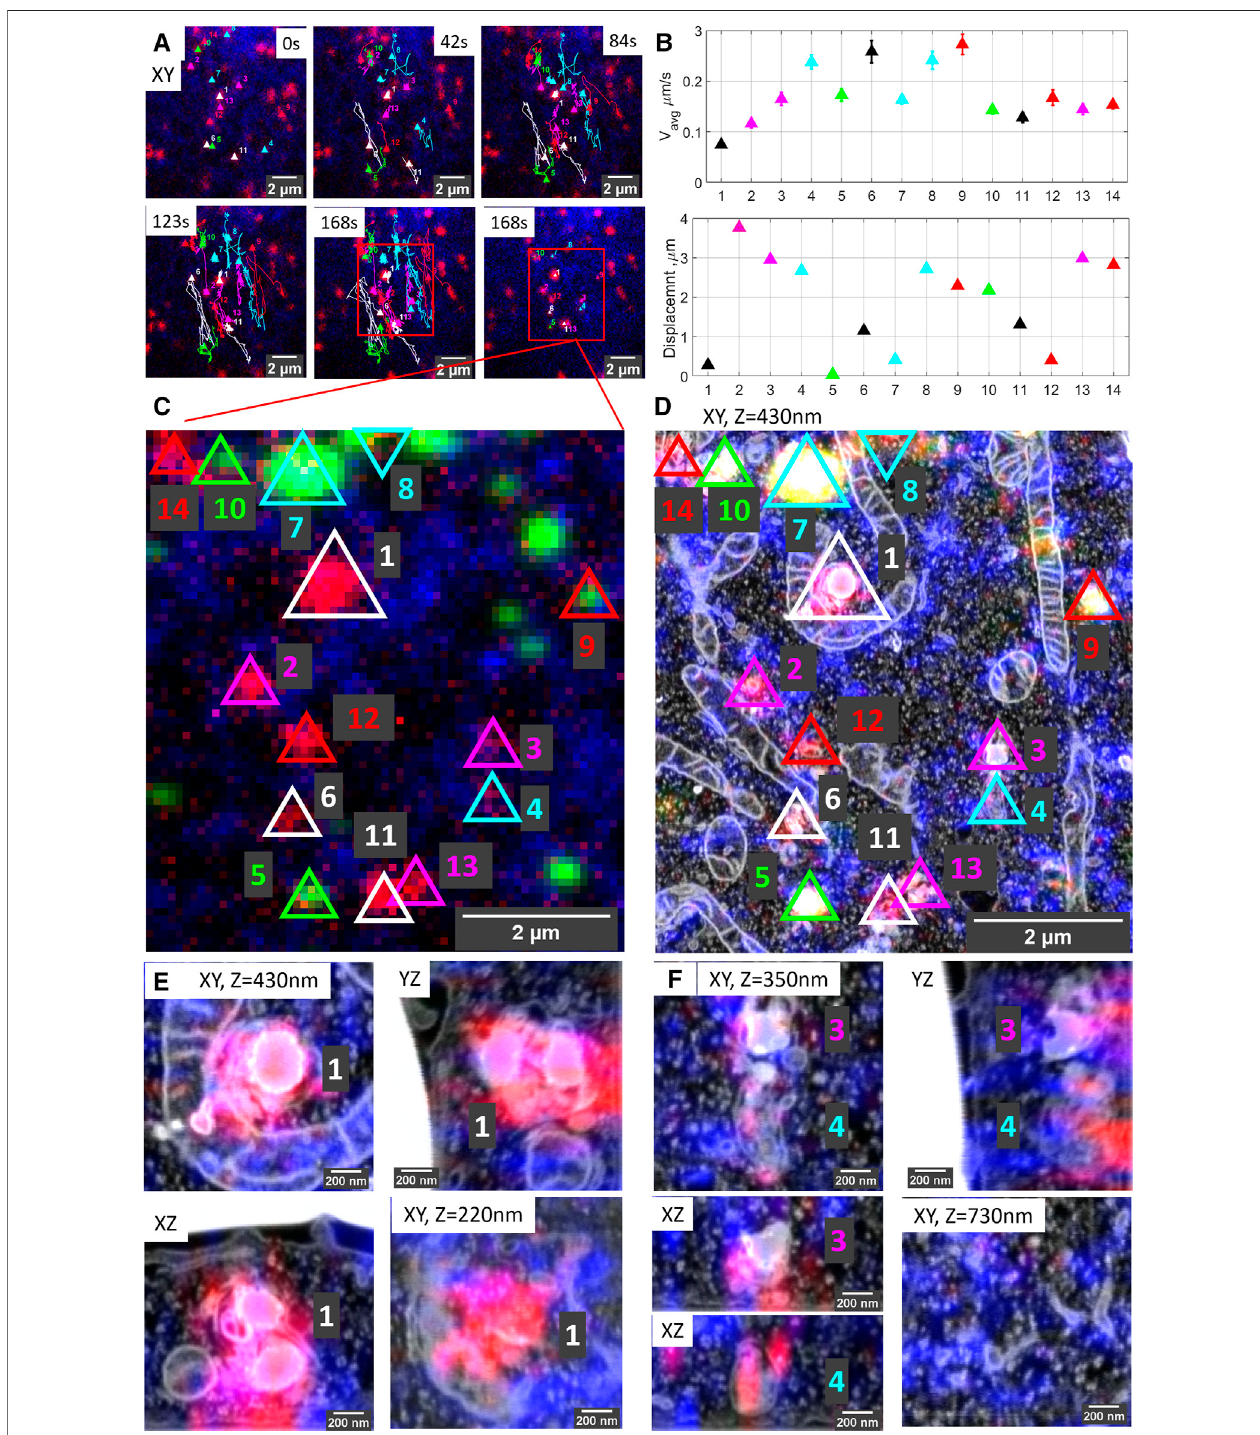
FIGURE2| Organelledynamicsdirectlycorrelatedtomorphology. (A) Time-lapseimagesfromlive-cellimaging.LysosomesarestainedwithSiRLyso (red)andER with mEmerald-Sec61 β (blue), and the cells have endocytosed fi ducial particles (green). We selected 14 SiRLyso positive, enzymatically active lysosomes and traced theirdynamicbehaviorover3 min. (B) Plotoftheaveragevelocity(µm/s)andtotaldisplacementofeachselectedorganelle,numberedfromlysosome#1tolysosome#14 in the x -axis. For example, lysosome#1 is very static, whereas lysosome#4 moves fast over extended distances. (C) Max intensity projection of CLSM stack recorded on the same cell after fi xation. Fiducial markers are visible in green. Each identi fi ed and analyzed organelle isnumbered as in (B) . (D) Following live-cell imaging and CLSM, cells are prepared for EM, imaged, and high-precision correlation is achieved using iCLSM-FIB.SEM. (E) Higher magni fi cation images of lysosome#1, lysosome#3, and lysosome#4 display their distinct morphologies from different planes and interaction with surrounding cellular organelles. See supplementary data for the rest of the lysosomes.